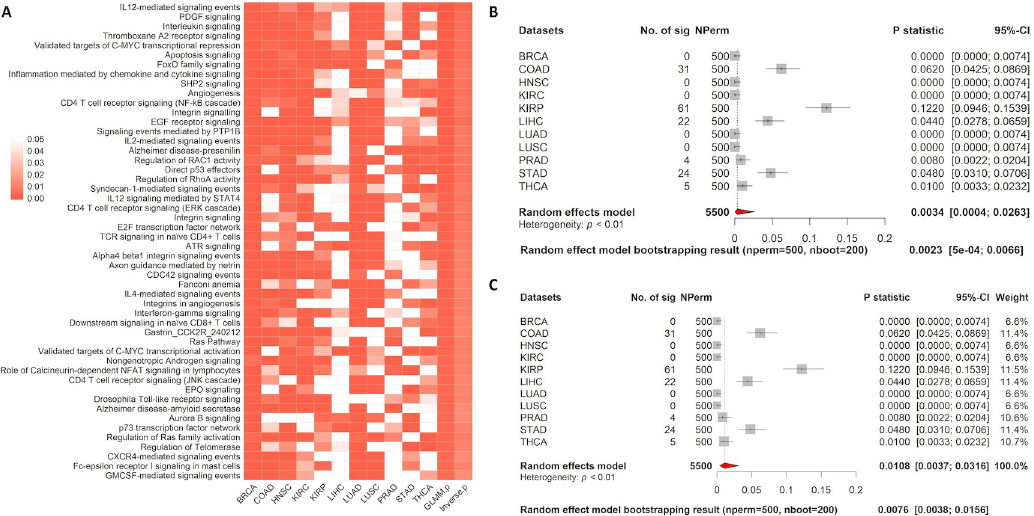
Fig 3. Pan-cancer MetaGSCA analysis in 11 cancer types, paired. A) The heatmap displays the top 50 pathways that MetaGSCA identified. The first 11 columns are the bootstrap p -statistic for each cancer type. Columns 12 and 13 are the meta-analysis p - statistics for the GLMM and the inverse variance method, respectively. B) Forest plot for the meta-analysis results of the valine , leucine , and isoleucine degradation pathway with the GLMM option. C) Forest plot for the meta-analysis results of the valine , leucine , and isoleucine degradation pathway based on the inverse variance method. In the forest plot, the dotted line denotes the meta p -statistic. Individual studies having stronger differential coexpression than the overall effect are on the left of the dotted line.